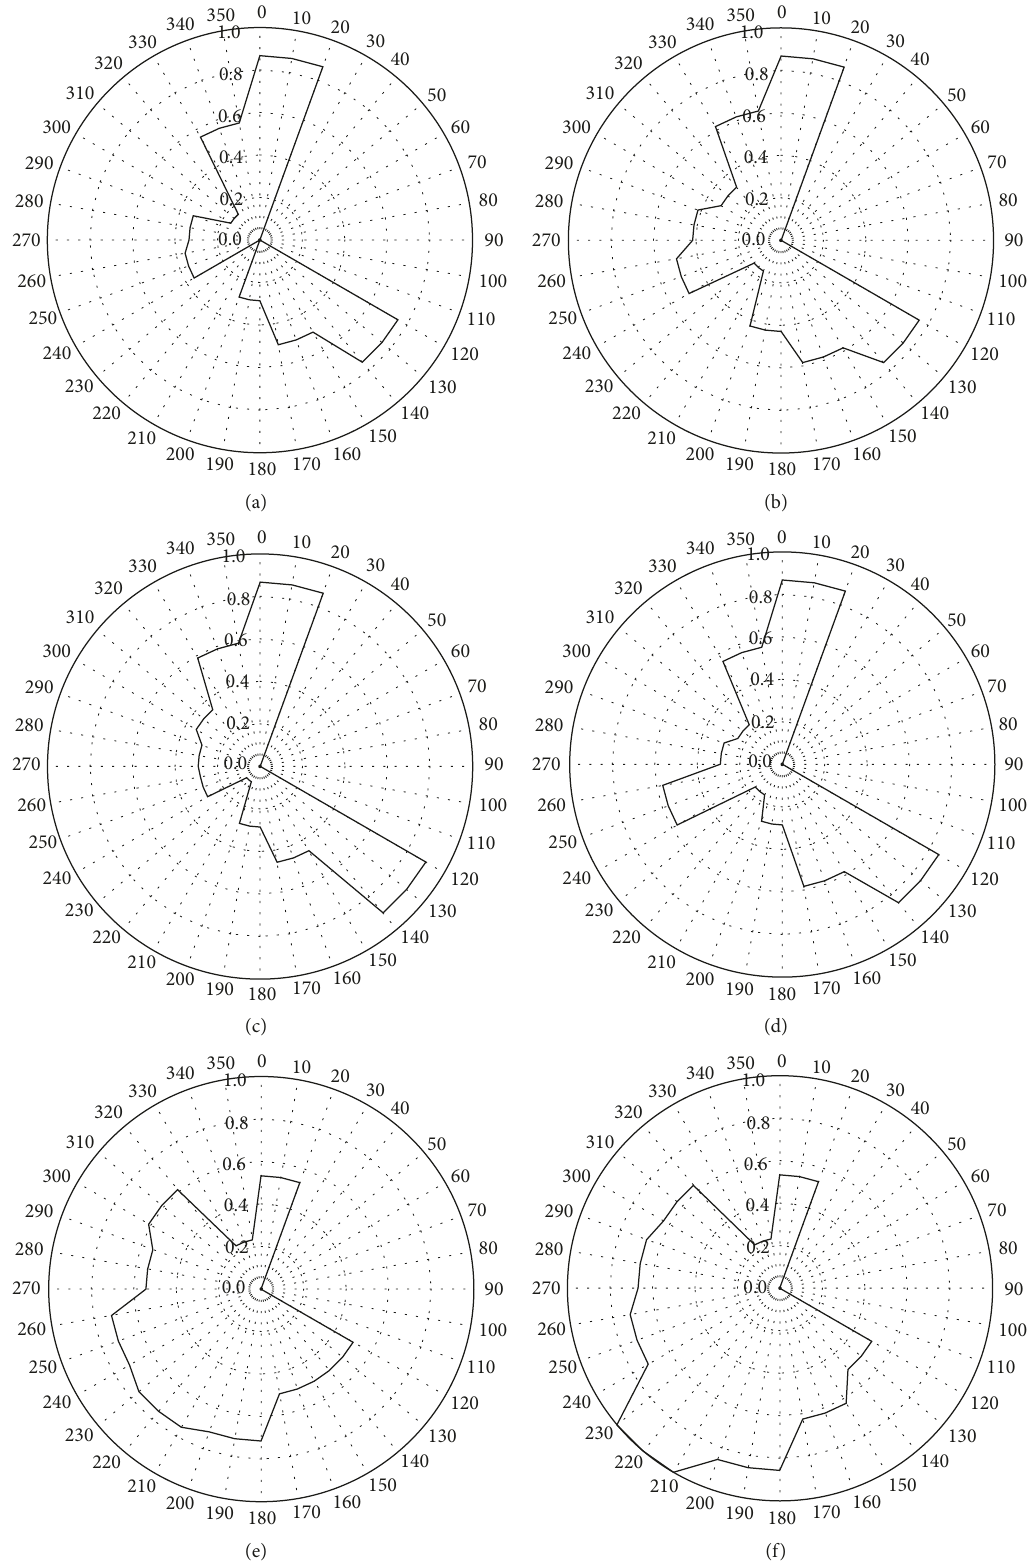
Figure 8: Rose plot of CPF for (a) the sum of PAHs, (b) the sum of hopanes, (c) the sum of n -alkanes, (d) the sum of 4-NO2-Phen and 2-OH-BA, (e) the sum of 3-OH-BA, 4-OH-BA, and 4-Me-PhA, and (f) the sum of o -PhA, m -PhA, p -PhA, 1,2,3-BA, 1,2,4-BA, and 1,2,4,5-BA at